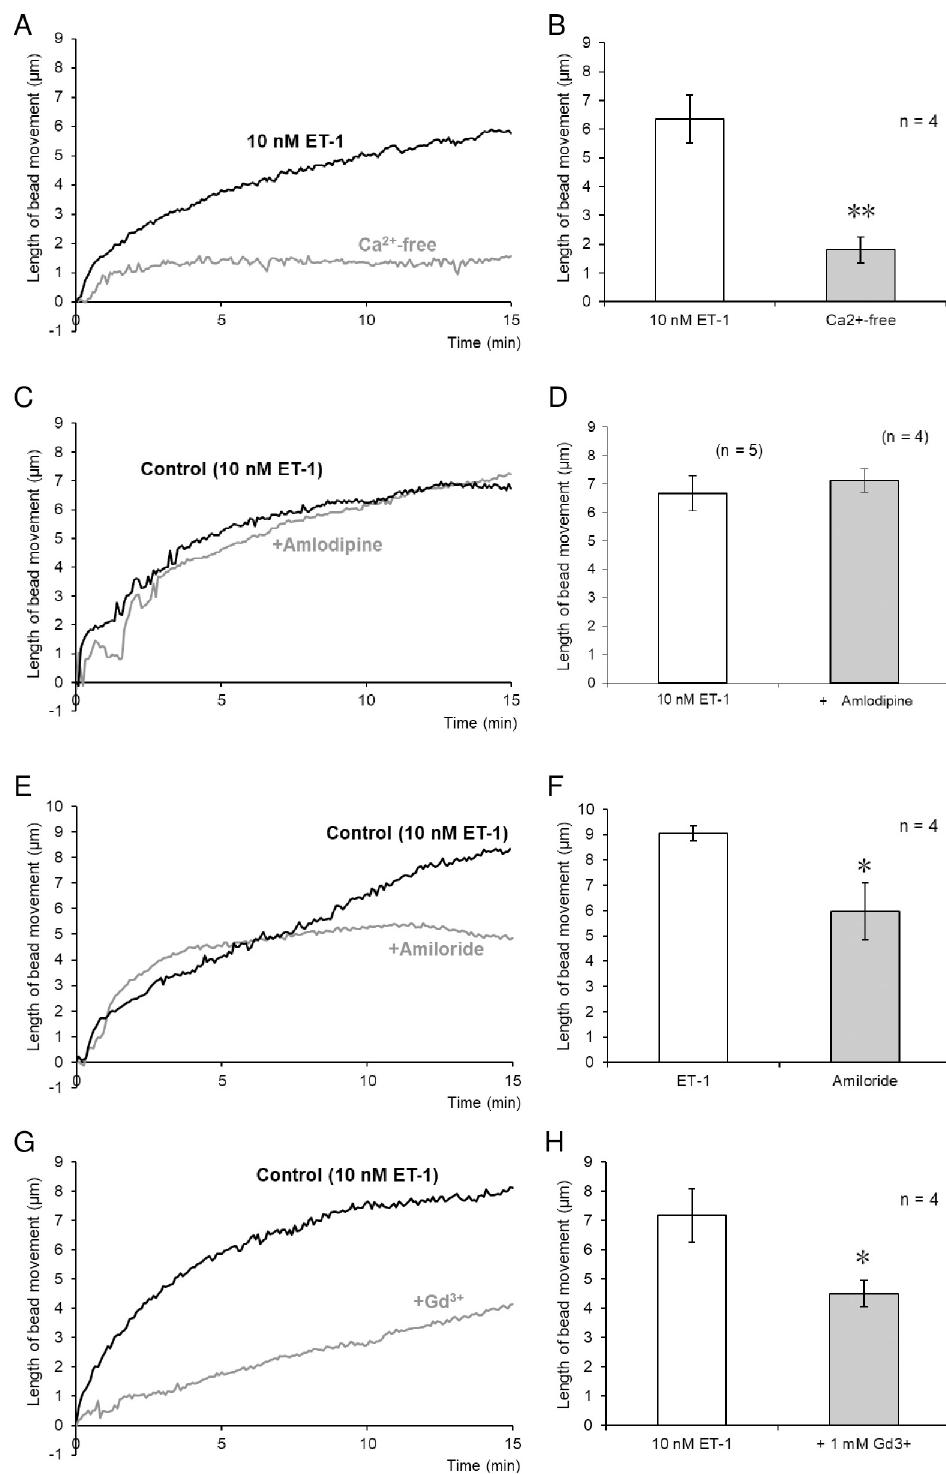
Fig 4. Involvement of Ca 2+ influx in ET-1-induced contraction of isolated mouse non-activated HSCs. (A–H) Effects of extracellular Ca 2+ removal, a Ca 2+ channel blocker, and cation channel blockers on ET-1-induced contraction. Traces represent typical time-courses of changes in length of bead movement after treatment with ET-1 (10 nM) in control and Ca 2+ -free solution containing 1.5-mM EGTA (A), or in the absence and presence of